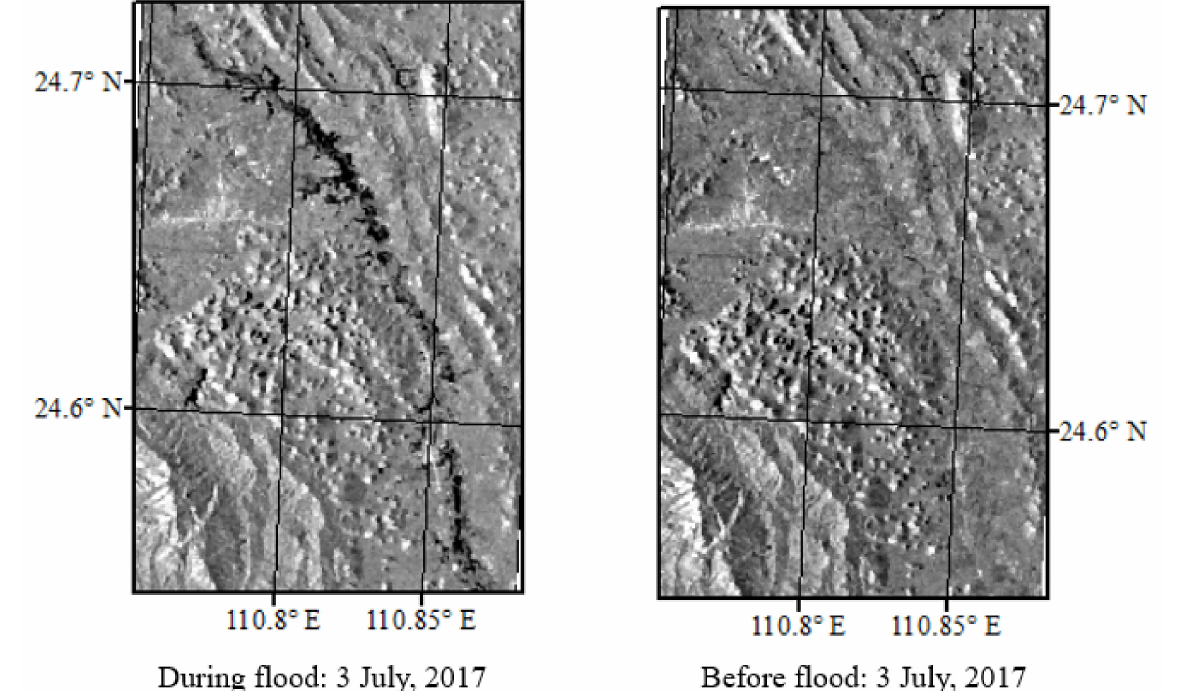
Figure 12. Flood event in 2017 along the Rongjin River and the original Sentinel-1 images.